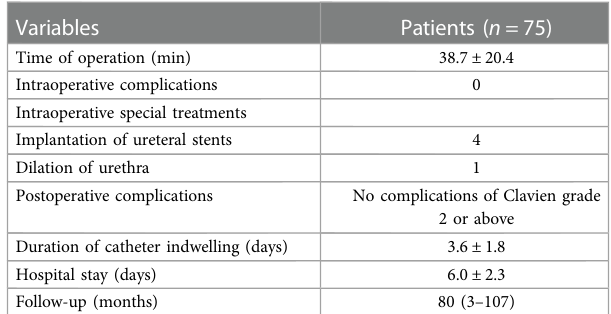
TABLE 2 Intraoperative and postoperative